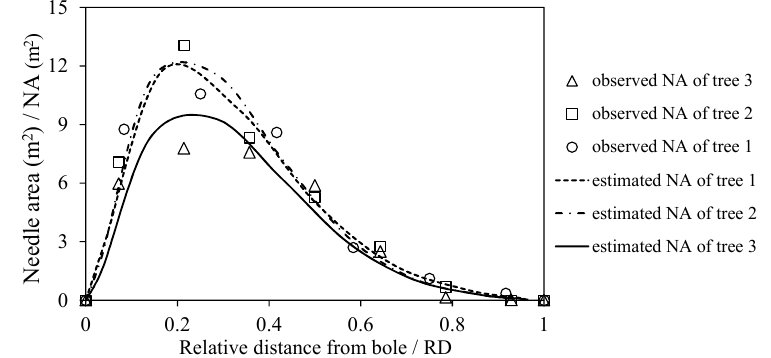
Figure 6. Description of the observed NA and corresponding estimated NA for three sample trees.